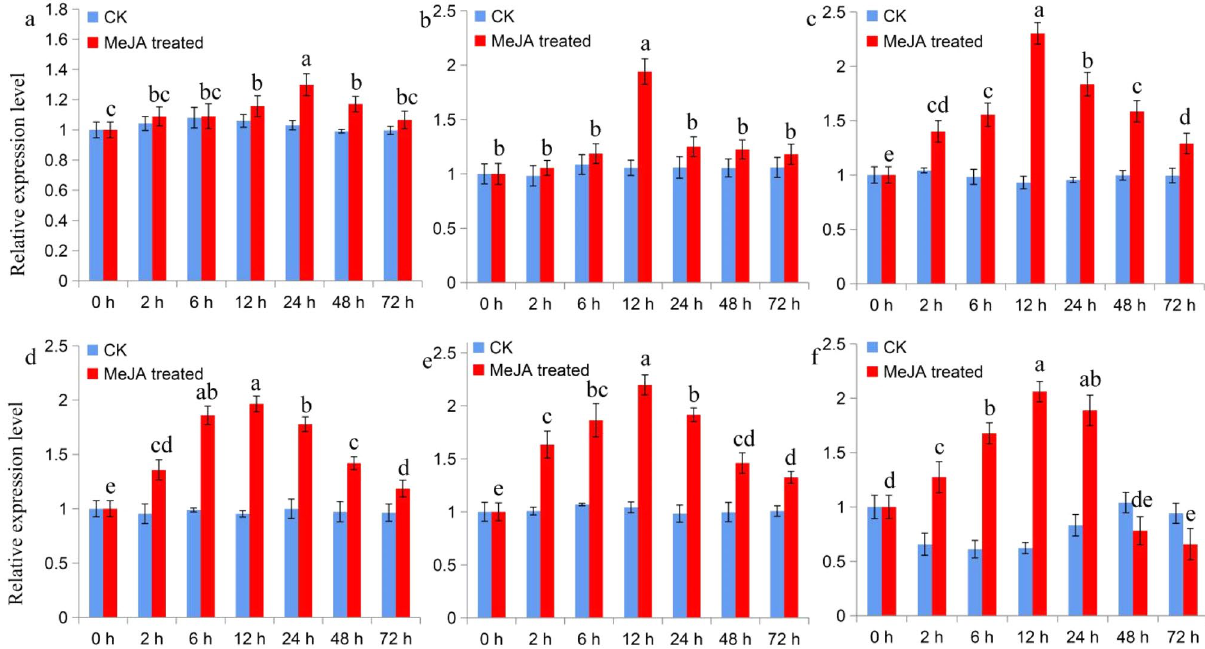
Figure 8. Level of SaMK and SaPMK transcripts in Santalum album roots ( a : SaMK , d : SaPMK ), shoots ( b : SaMK , e : SaPMK ) and leaves ( c : SaMK , f : SaPMK ) after induction with MeJA. The gene expression level of SaMK and SaPMK (untreated control) was set to 1. Data from qRT-PCR are means ± SD (standard deviation) from triplicate experiments (n = 3) and different letters indicate significant differences (p < 0.05) according to Duncan’s multiple range